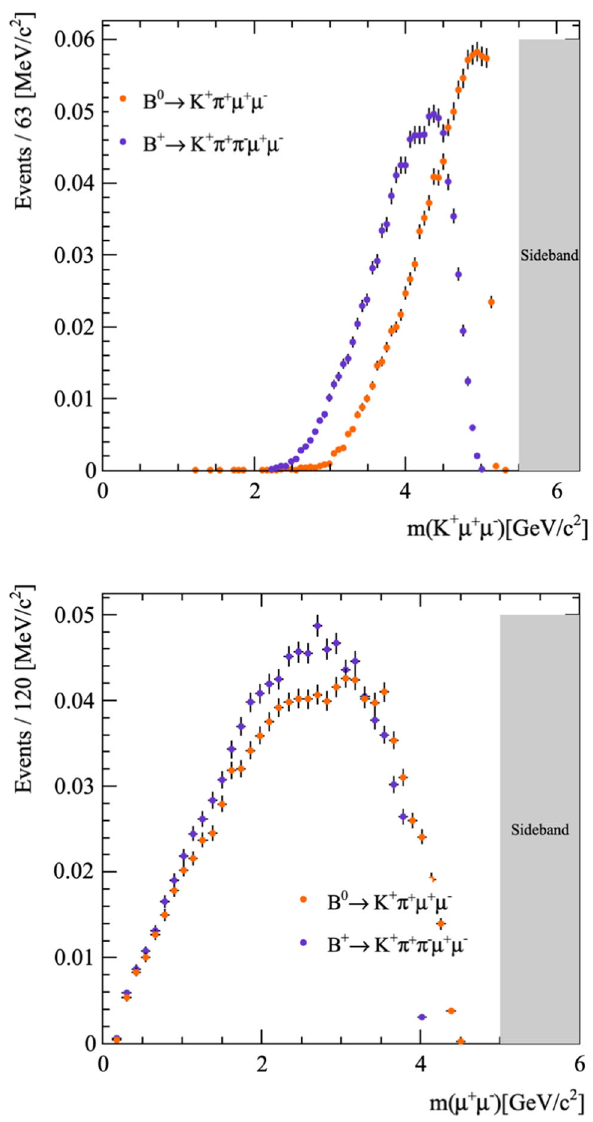
Fig. 1 Comparison of the K + μ + μ − invariant mass combination (left) and di-lepton invariant mass (right) for partially reconstructed B 0 → K + π − μ + μ − and B + → ( K 1 ( 1270 ) + → K + π − π + )μ + μ − decays. The sideband region is also shown. The greyed out areas correspond to the sideband. These distributions were produced using the fast simula- tion [47] described in the text